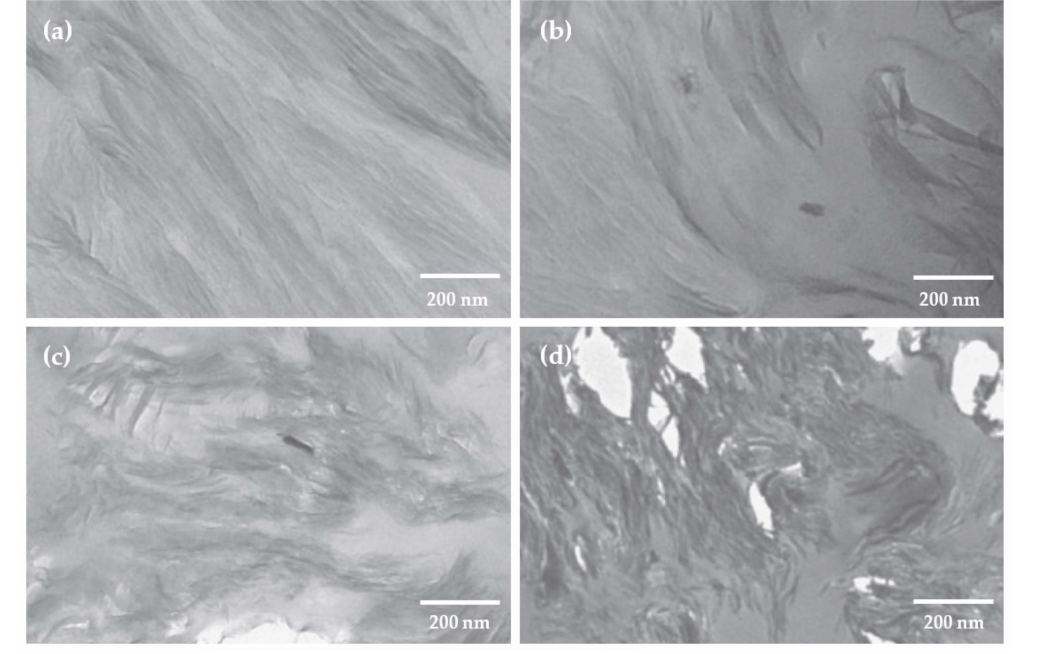
Figure 23. TEM micrographs of TPS matrix with different nanoclay concentrations in wt %: ( a ) 1, ( b ) 2, ( c ) 3, ( d ) 5. Reproduced with permission from J. Plast. Film Sheeting , 32 , Mohan and Kanny, Thermoforming studies of corn starch-derived biopolymer film filled with nanoclays, 163–188, 2016